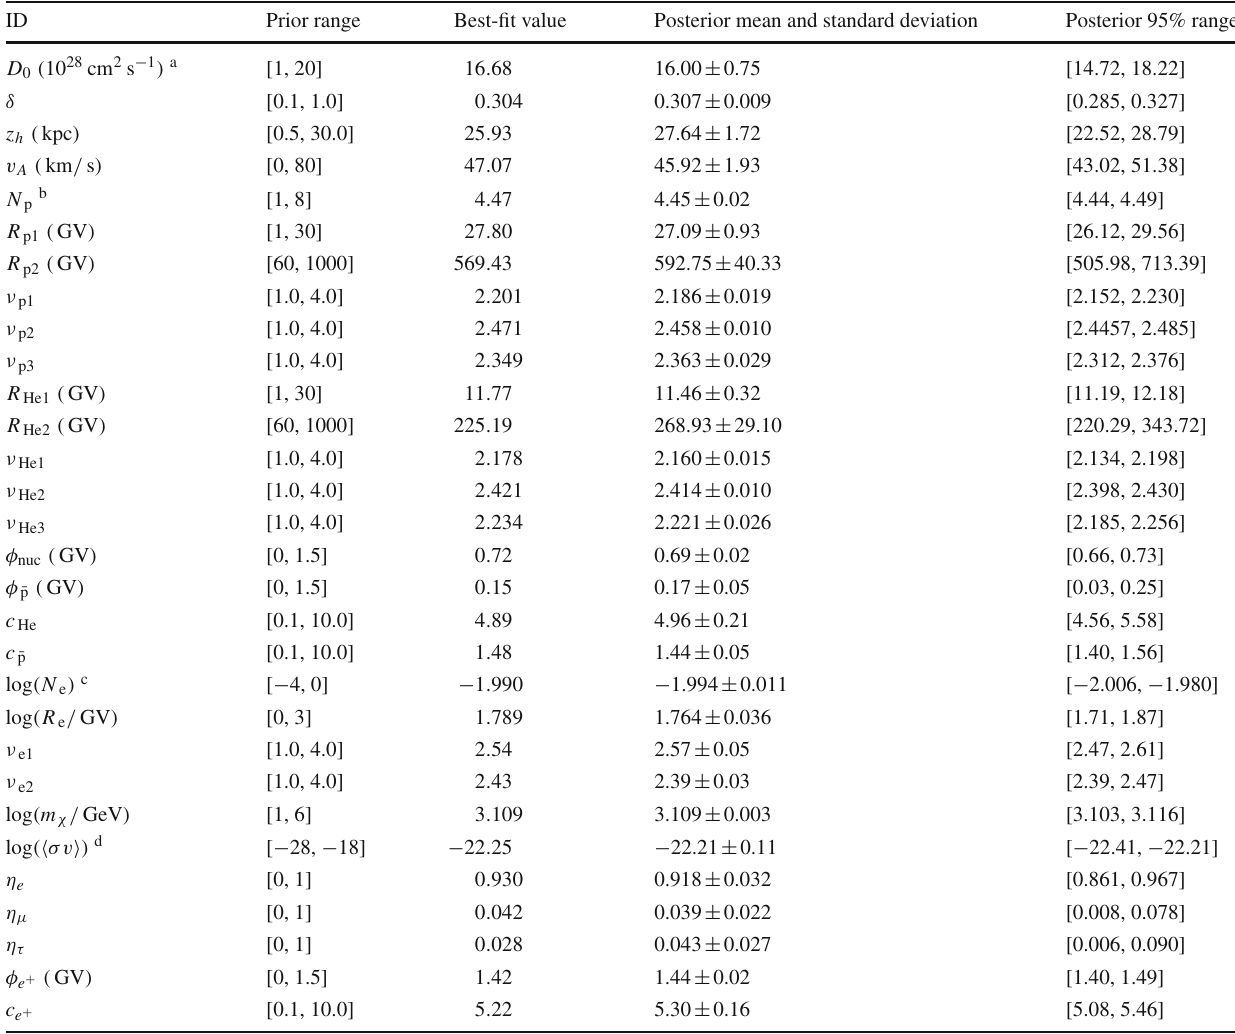
Table5 ConstraintsontheparametersofCALETCREspectrum,pulsarscenario.Thepriorinterval,best-fitvalue,statisticmean,standarddeviation and the allowed range at 95% CL are listed for the parameters. For the best-fit values, we have χ 2 / d . o . f . = 265 . 03 / 299